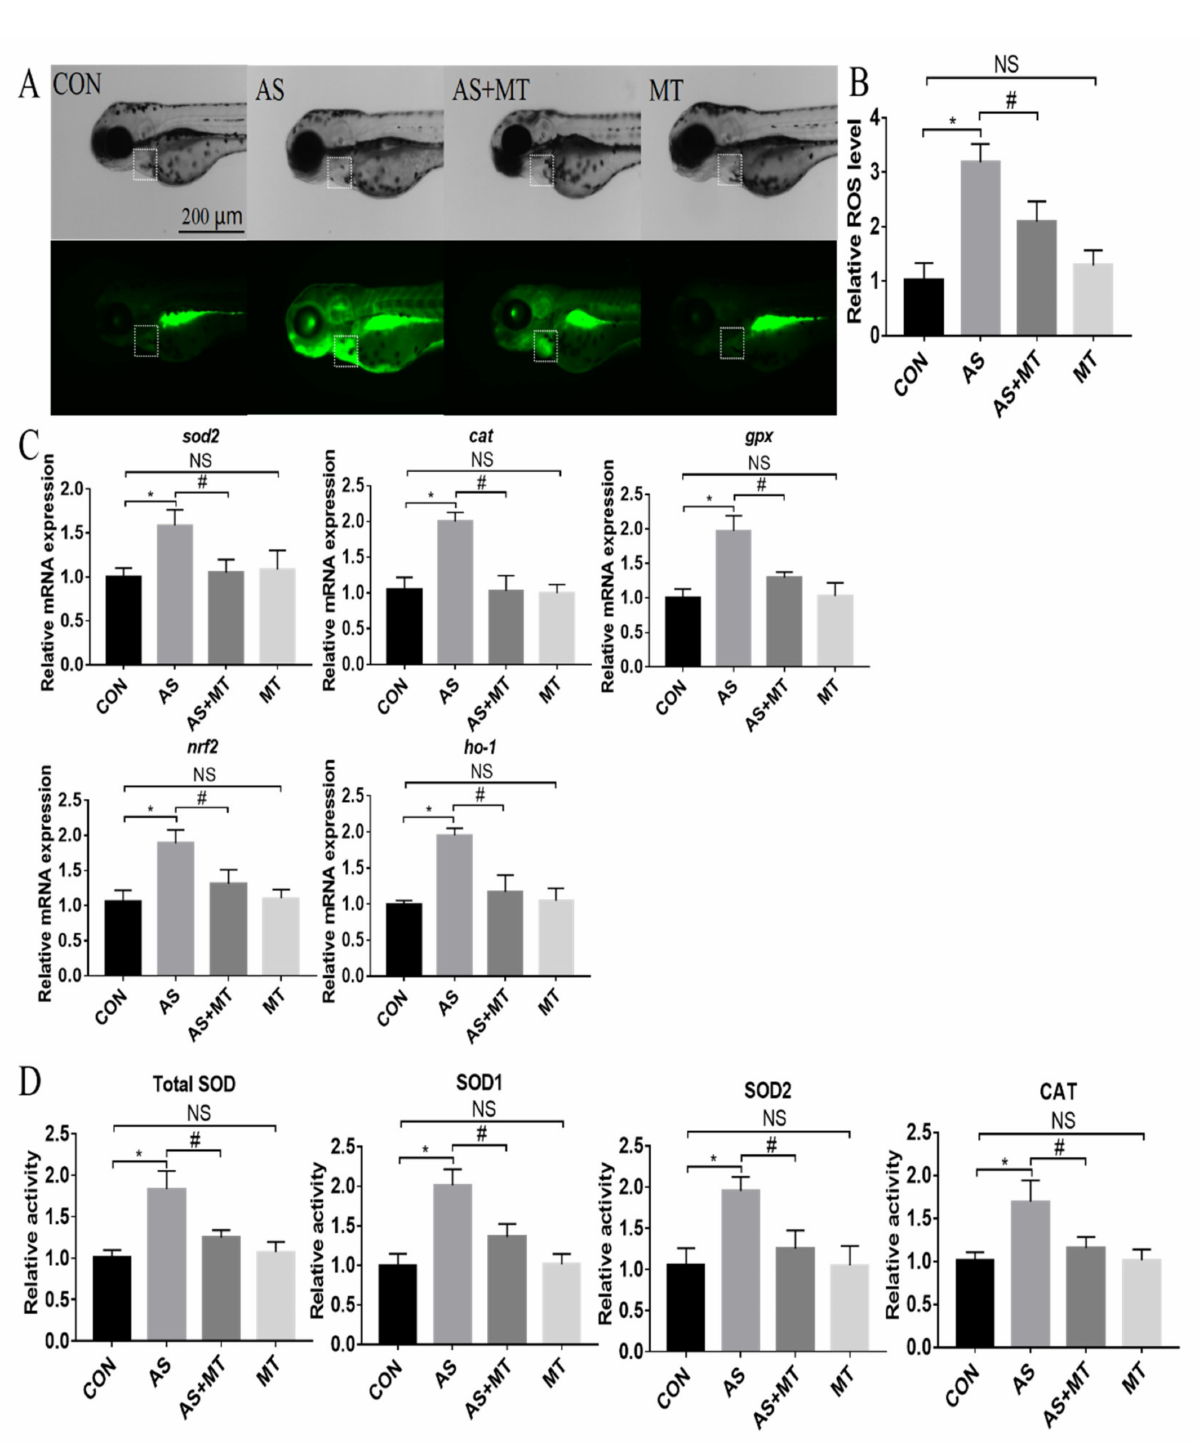
Figure 2. The effects of melatonin on the NaAsO 2 -induced oxidative stress changes in zebrafish embryos at 72 hpf. ( A ) ROS signals in the heart area and heart regions are represented by the dotted squares. ( B ) Quantification of ROS signals in heart area. ( C ) Relative expression levels of oxidative stress-related genes. ( D ) Relative enzyme activities. CON: system water as the vehicle control; AS: NaAsO 2 at 1.0 mM; MT − 9 : Melatonin at 10 − 9 M. * p < 0.05, compared to CON; # p < 0.05, compared to MT; NS, compared to